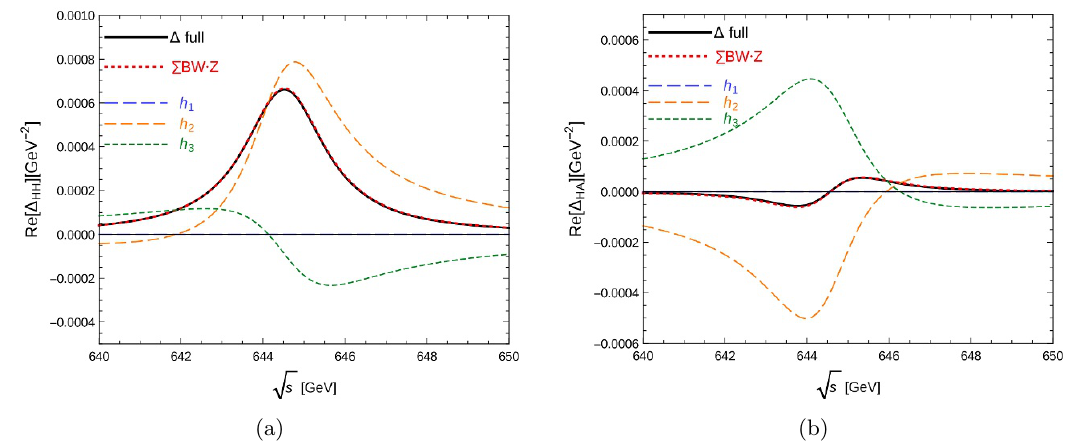
Figure 9 . Real parts of (a) the diagonal propagator (cid:1) HH ( p 2 ) and (b) the o(cid:11)-diagonal propagator (cid:1) HA ( p 2 ) depending on the real momentum p 2 = s around